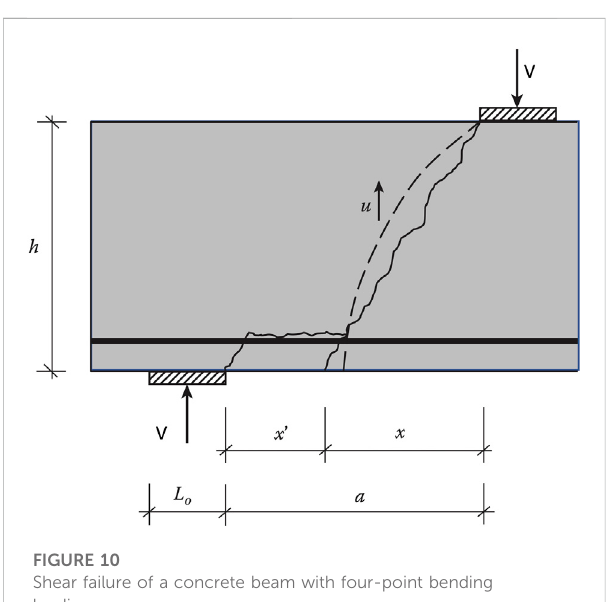
FIGURE 10 Shear failure of a concrete beam with four-point bending